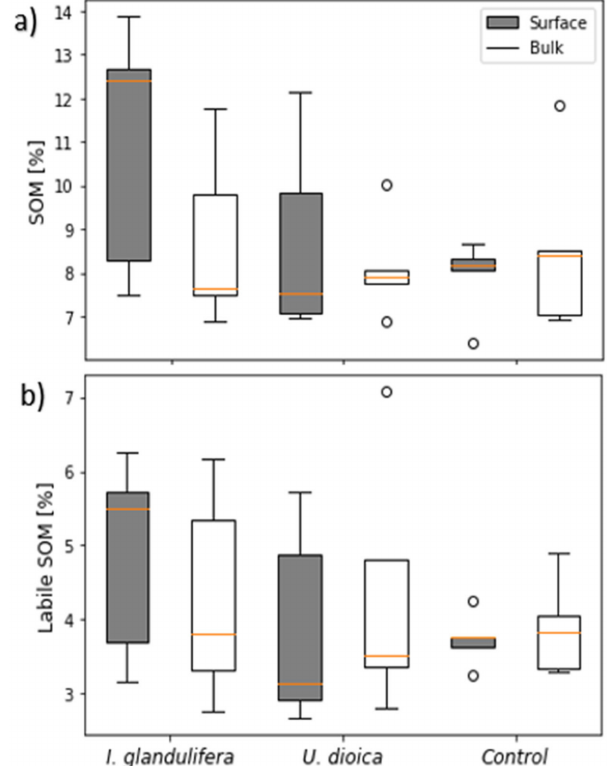
Figure 2. Percentage of ( a ) total soil organic matter (SOM) and ( b ) labile soil organic matter (Labile SOM) on a dry mass basis for surface (0–2 cm) and bulk layers (2–5 cm depth) of soil colonized by Impatiens glandulifera ( I. glandulifera ) and by Urtica dioica ( U. doica ) or of bare soil (Control) obtained as thermogravimetric mass loss between 200 and 600 ◦ C. The boxes present the lower and upper 25th percentiles with whiskers showing the 1.5 fold interquartiles range (IQR) and all data points outside the 1.5 fold IQR depicted as empty circles.